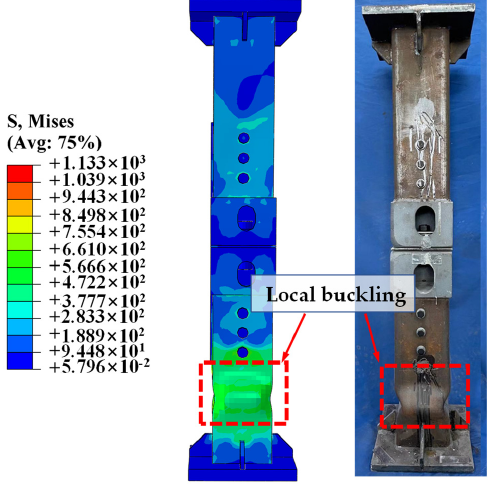
Figure 17. Comparison of failure